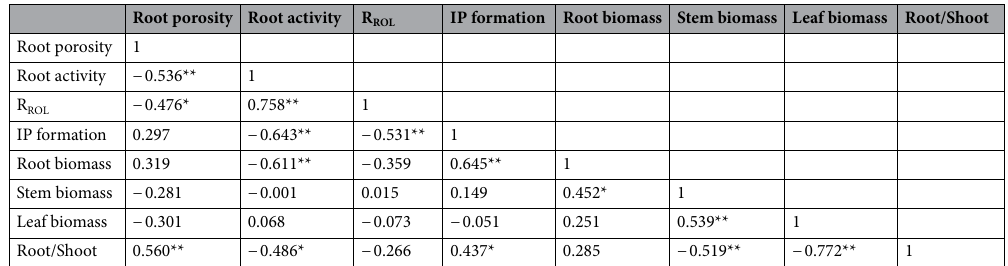
Table 2. The correlation coefficients (r) between root growth characteristics and IP formation in Kandelia obovata. Shoot = stem + leaf. *, P < 0.05. **, P < 0.01. R ROL rate of ROL.